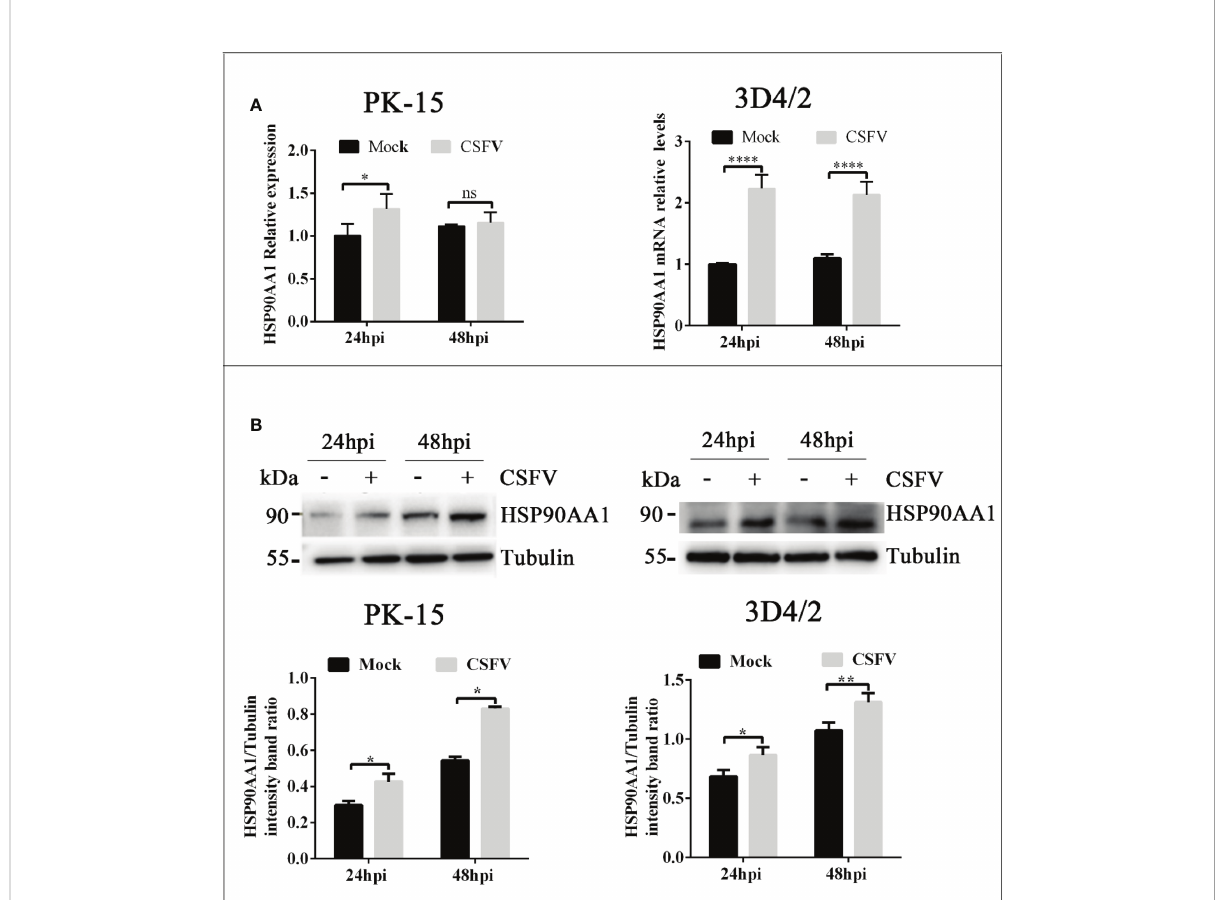
FIGURE 1 CSFV infection Up-regulates HSP90AA1 expression. (A) HSP90AA1 mRNA relative levels in PK-15 and 3D4/2 cells was analyzed by qRT-PCR; (B) Western blot showing HSP90AA1 protein expression and the relative protein levels of HSP90AA1 in PK-15 and 3D4/2 cells were estimated by histograms representing density readings of the gel bands with Image J, and the ratios were calculated relative to Tubulin control. (*p < 0.05, **p < 0.01 and ****p < 0.0001 calculated using two-way ANOVA, ns, not signi fi